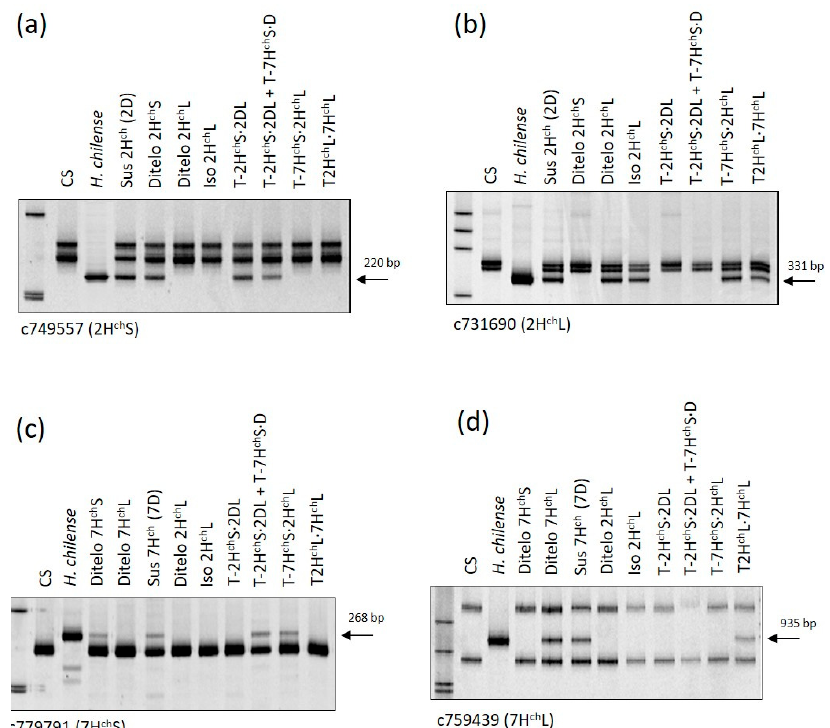
Figure 3. Examples of PCR amplification profiles used for identifying chromosome 2H ch and 7H ch arms in the introgression lines. ( a ) c749557 mapped on the short arm of chromosome 2H ch ; ( b ) c731690 mapped on the long arm of chromosome 2H ch ; ( c ) c779791 mapped on the short arm of chromosome 7H ch ; and ( d ) c759439 mapped on the long arm of chromosome 7H ch . “Chinese Spring” (CS), H. chilense (H ch ), ditelo 2H ch S, ditelo 7H ch S, ditelo 7H ch L and disomic substitution line CS 7H ch (7D) were used as controls.